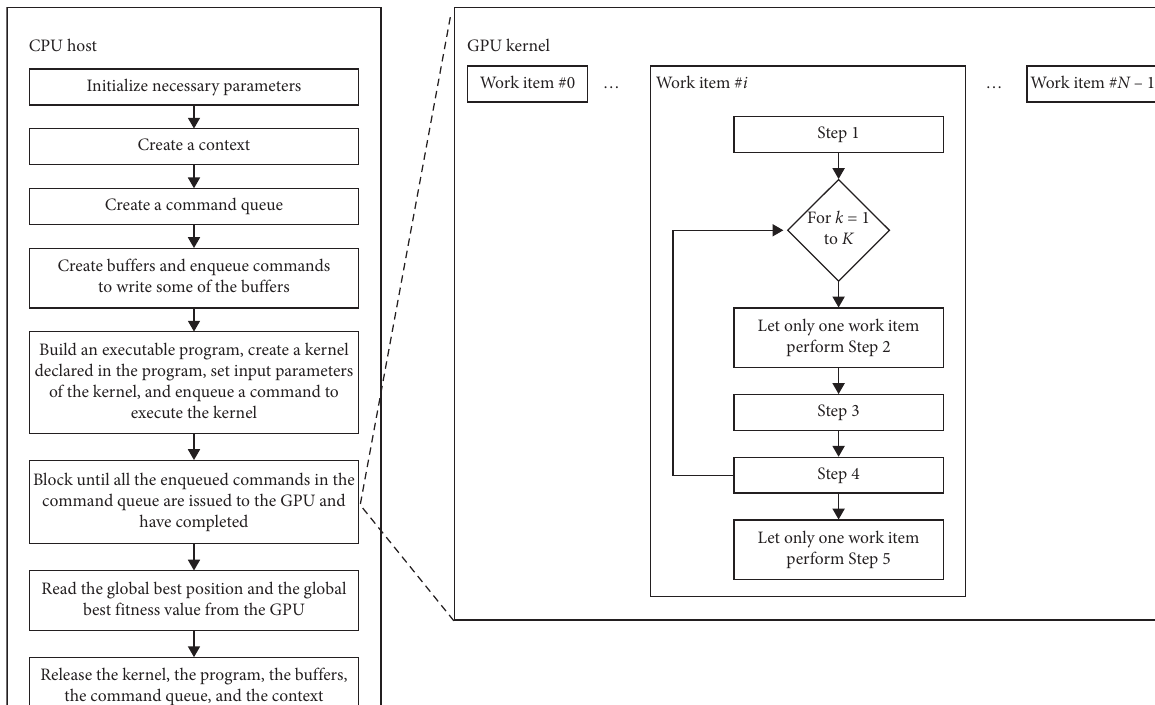
Figure 4: Basic coarse-grained all-GPU